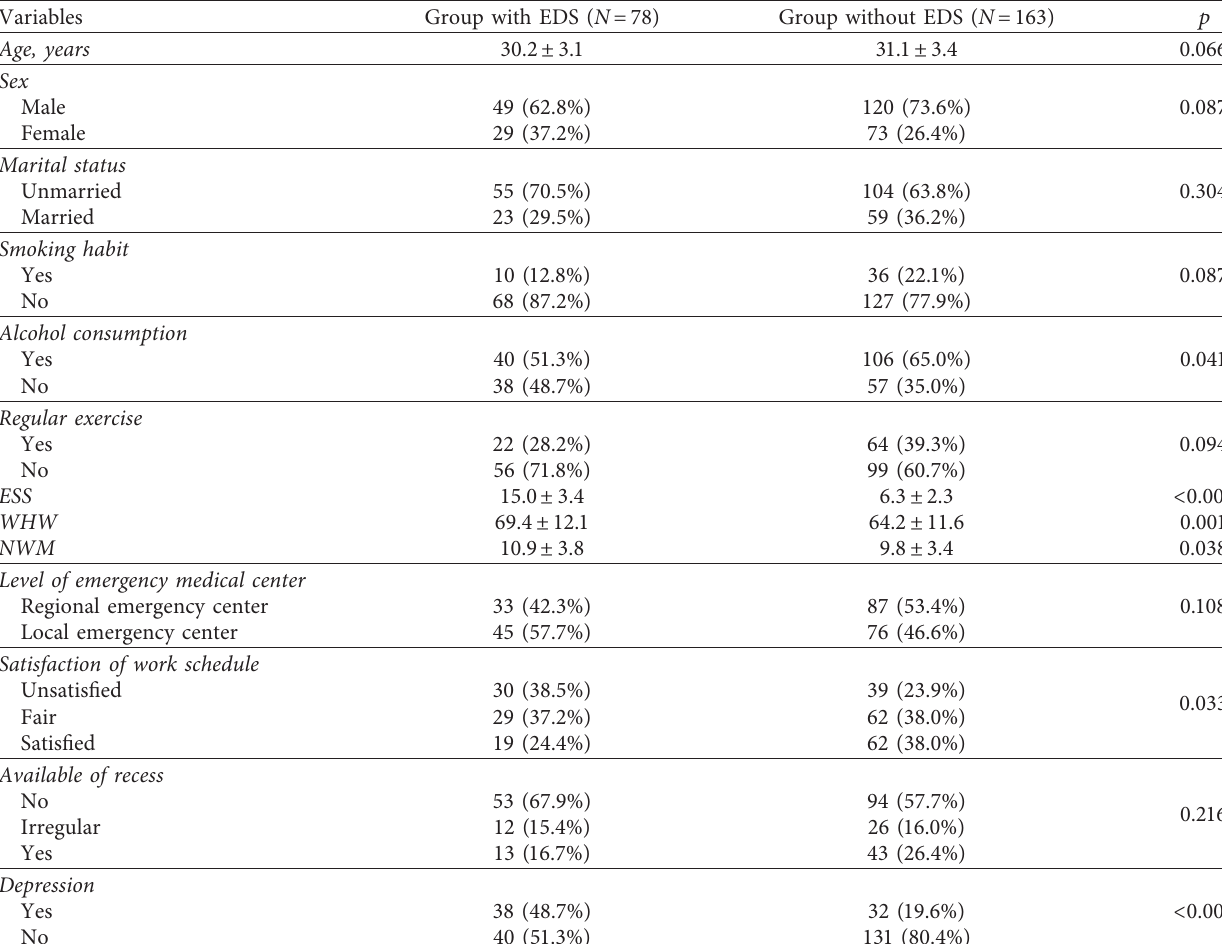
Table 2: Comparison of the demographic characteristics and work environment of the EM residents according to